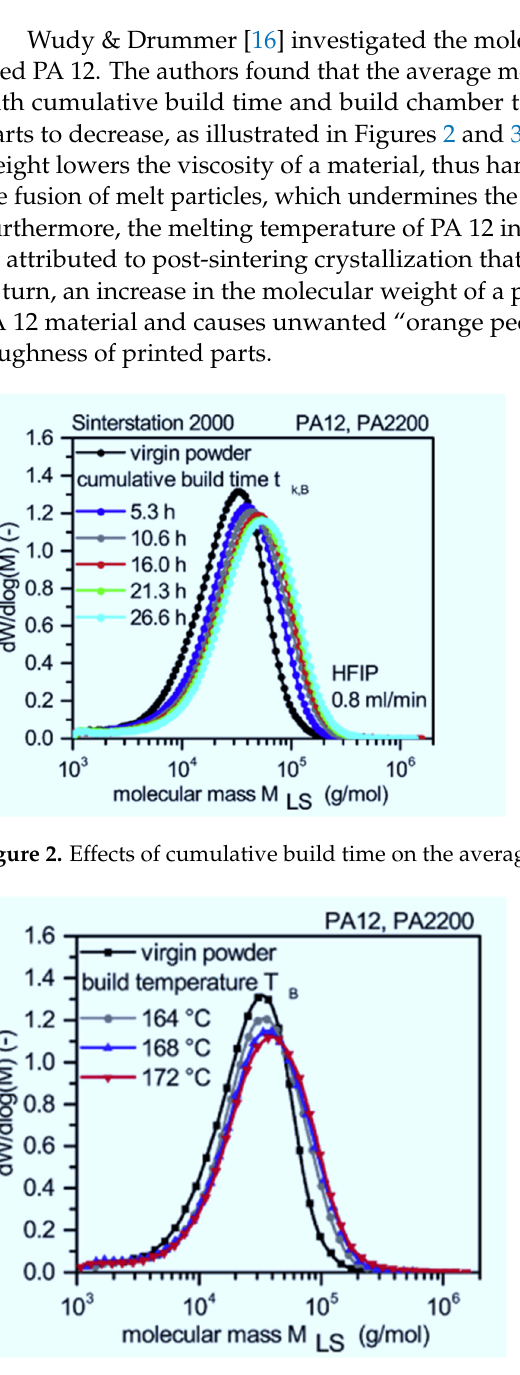
Figure 3. Effects of build chamber temperature on the average molecular weight of PA 12 [16].